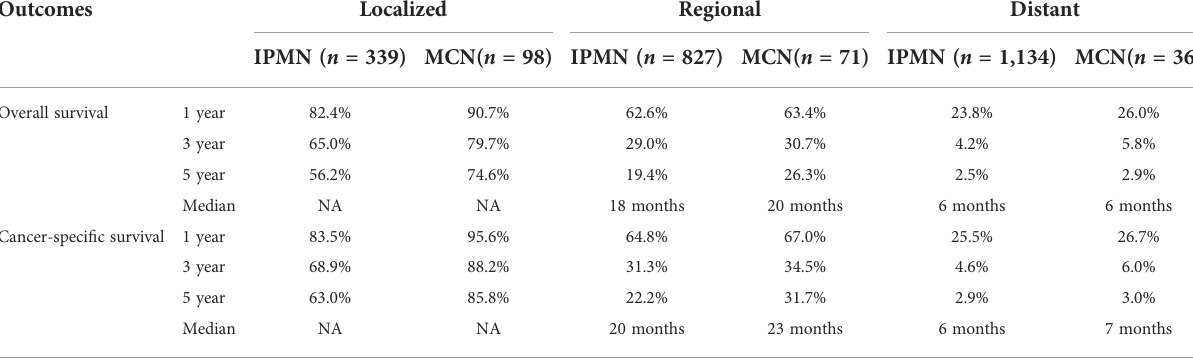
TABLE 3 Survival outcomes of patients with IPMN and MCN in different